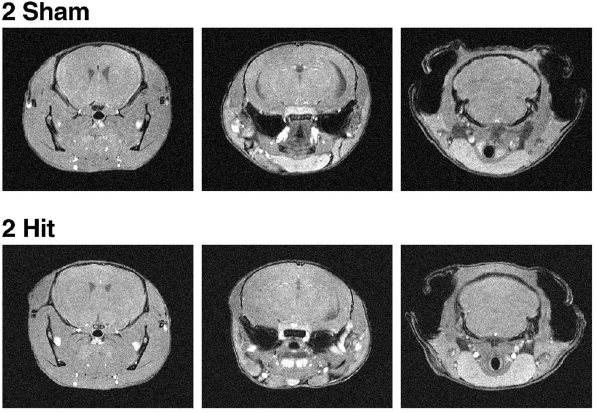
Fig. 5. Wildtype mice show no focal radiographic abnormalities on MRI after 2-hit injury. Wildtype mice (n 5 6 per group) received a 2-hit frontal impact injury or sham treatment. Their brains were imaged by MRI two days after the second injury. (A–B) Representative T1 weighted coronal images of sham treated (A) and 2-hit injured (B)